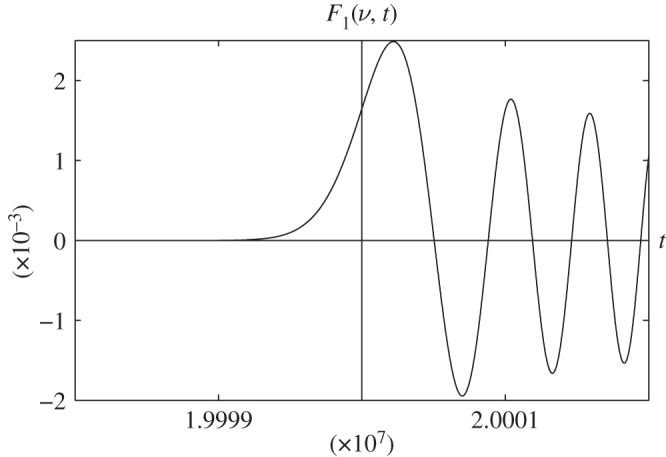
Plot of the function F1(ν, t) for ν=20000000.2.